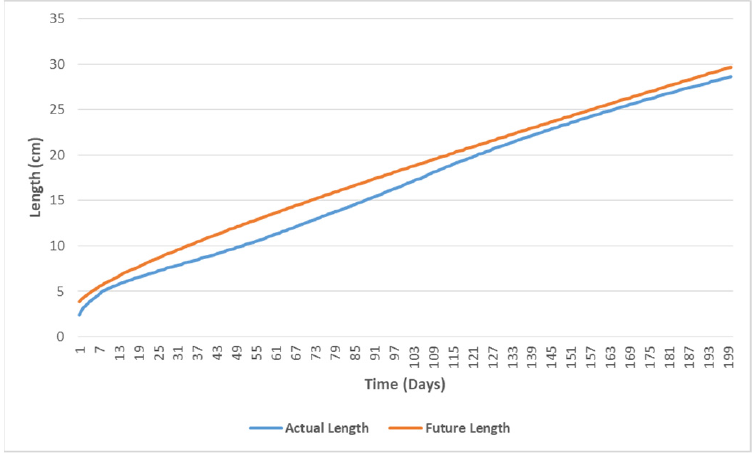
Figure 17. Fish length adjustment.